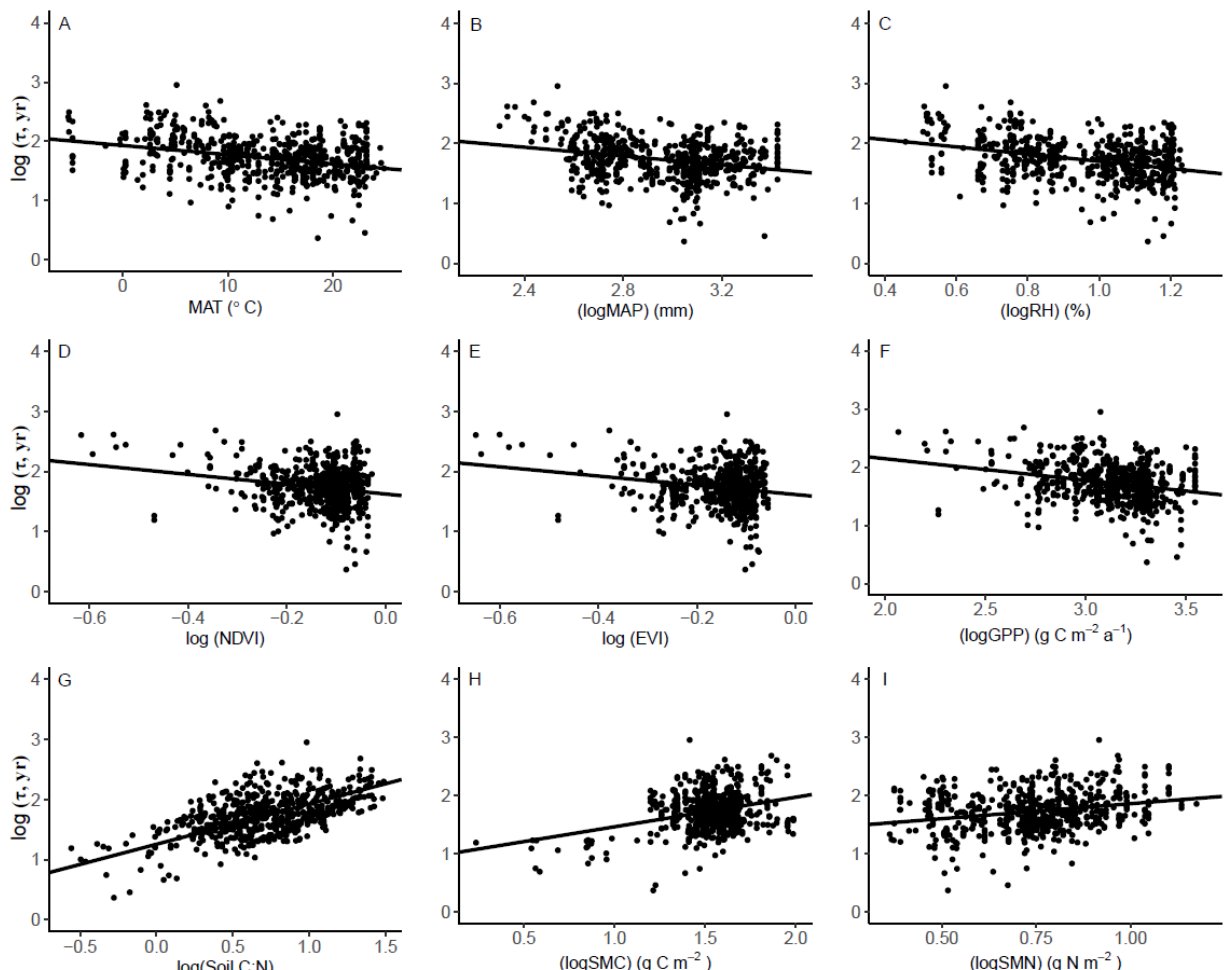
Figure 3. The variation of C turnover time ( τ , naturally log-transformed) according to climatic, soil, and vegetation variables, etc., in the sample mean ( A – I ) are constant. The fitted lines were determined by GLMM, with stand types as the random factor. The parameters are shown in Table 2.